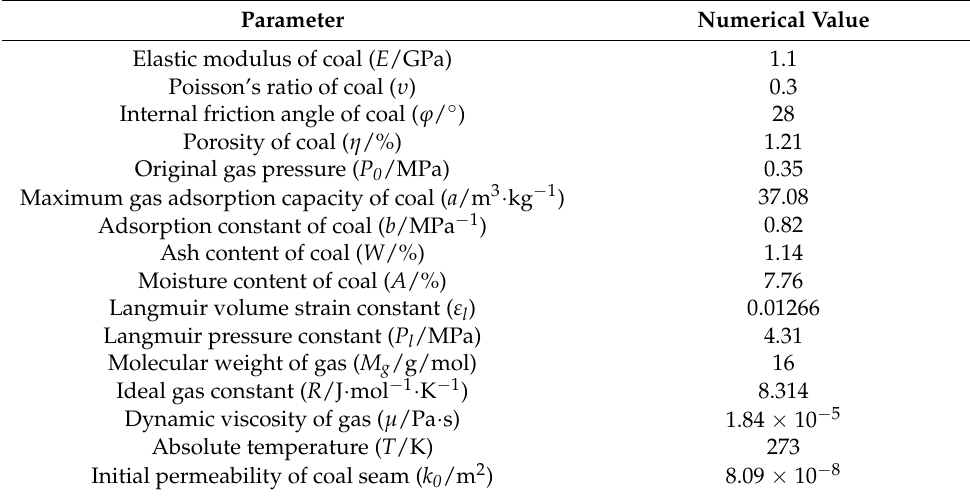
Figure 6. Numerical model. Table 4. Numerical calculation